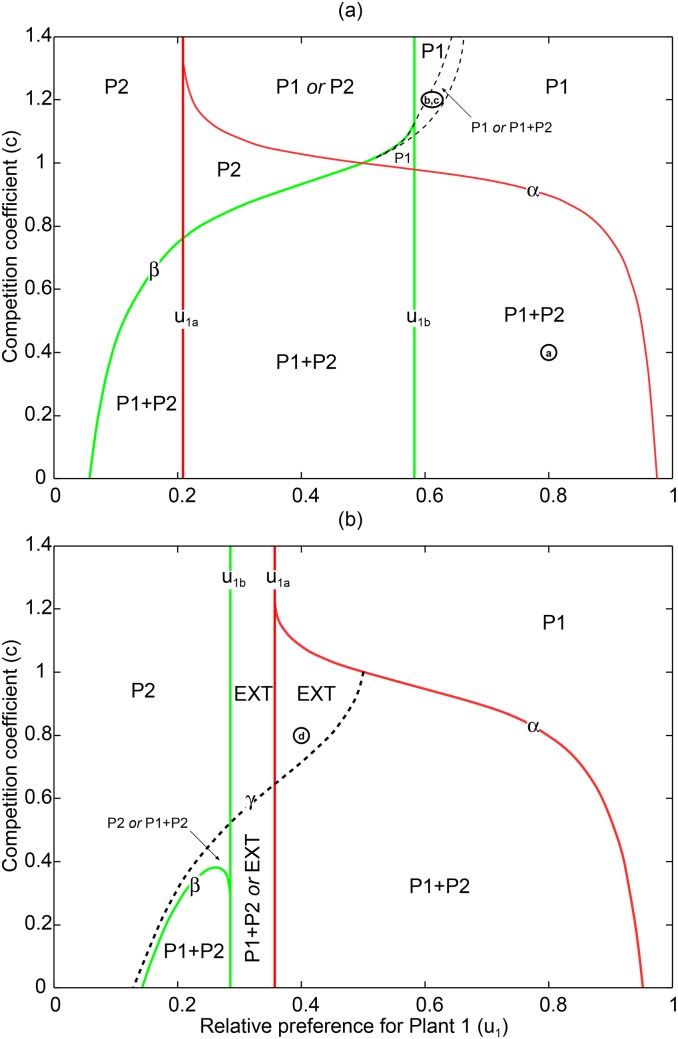
Interaction outcomes as a function of competition strength and fixed pollinator preferences.Solid lines (coloured, found analytically) determine regions where single plant equilibria exist and whether they can be invaded or not. Dashed lines (in black, found numerically, like γ) determine outcomes that cannot be predicted by invasibility analysis. Plant 2 can invade Plant 1 in the region between the red vertical line u1a and the red curve α. Plant 1 can invade plant 2 in the region between the green curve β and the green vertical line u1b. The final composition of the community is indicated by P1 = plant 1 wins, P2 = plant 2 wins, P1 + P2 = coexistence, EXT = extinction of all species; the “or” separator indicates that the outcome depends on the initial conditions. Parameters from Table 1, with (a) Ki = 60 and (b) Ki = 35 (i.e., above and below critical K* = 37.5, see Eq (10)). Representative dynamics for parameter combinations at ⓐ, ⓑ, ⓒ and ⓓ are illustrated in corresponding panels of Fig 3.